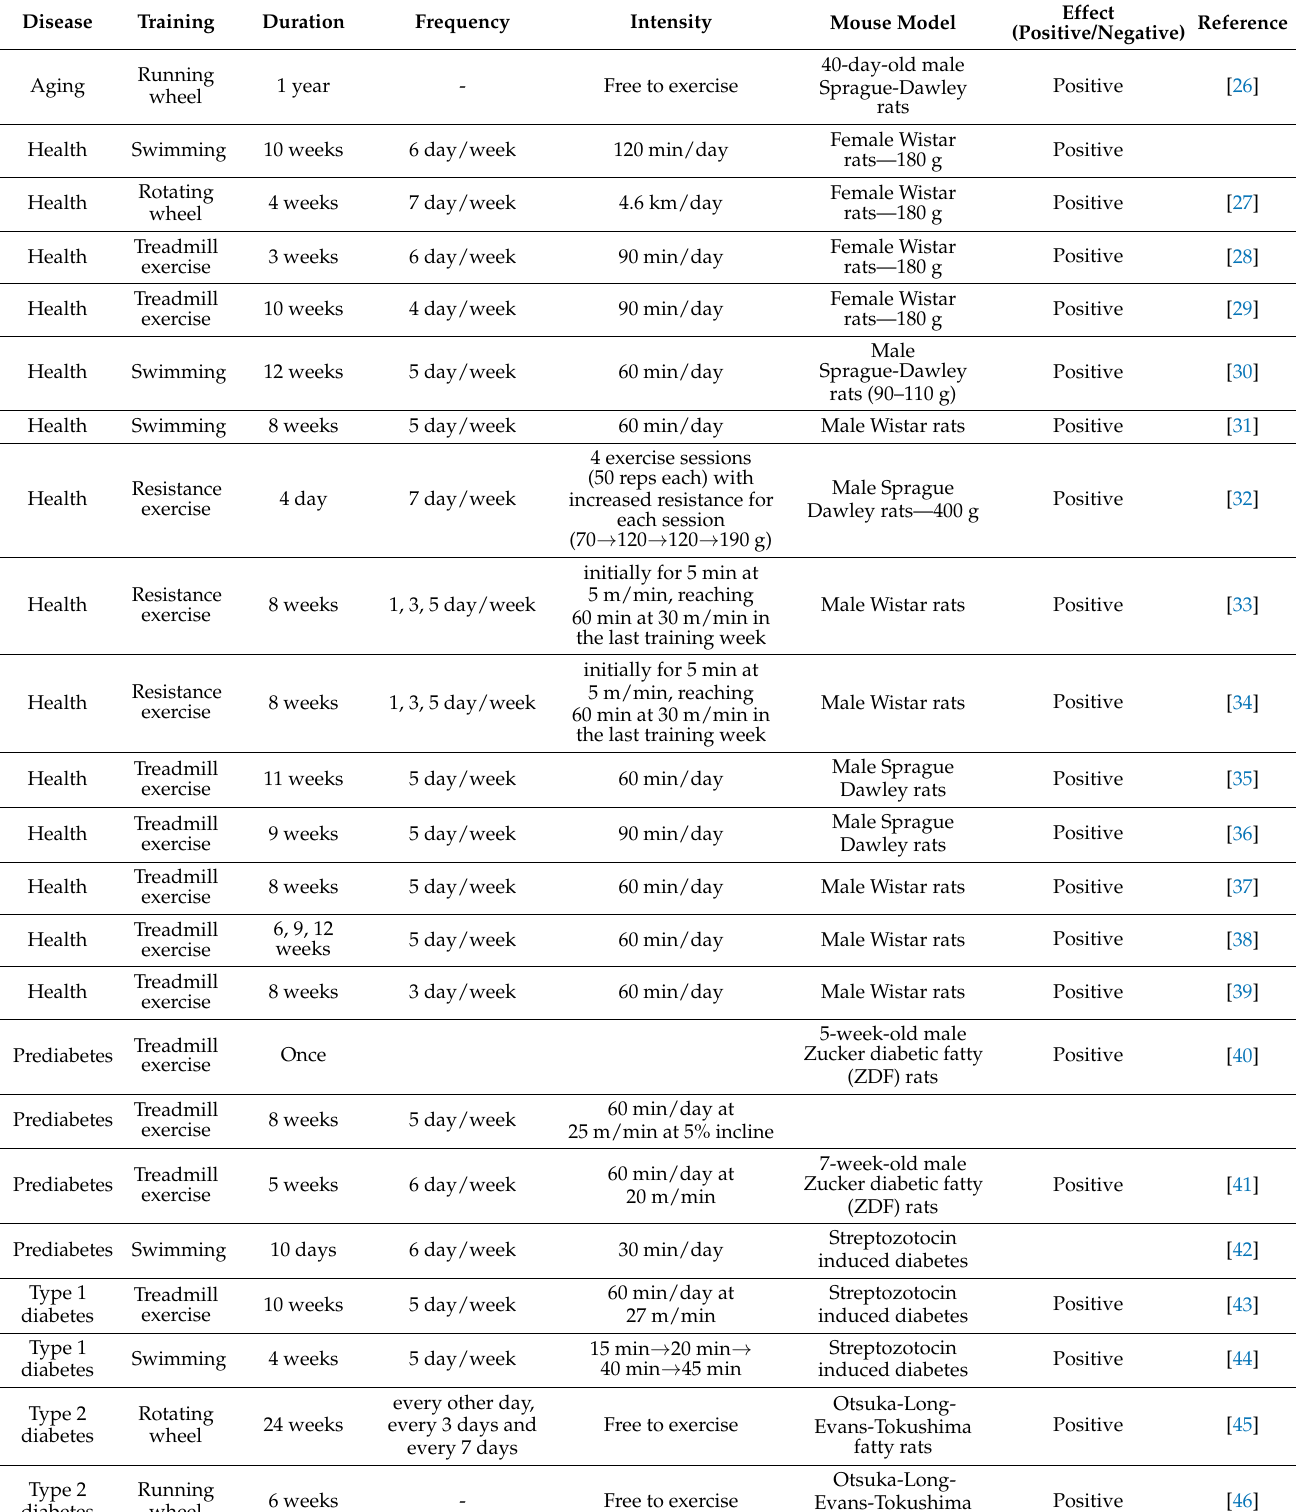
Table 3. Exercise intervention characteristics of the included rats model